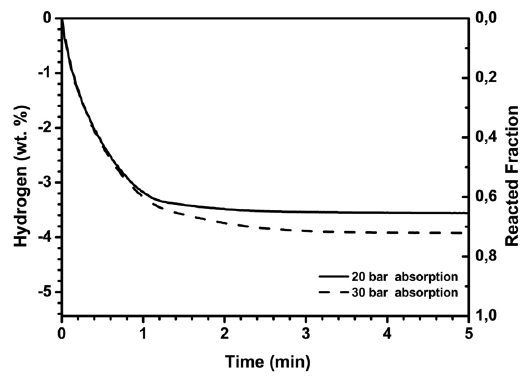
Figure 5. Curves of hydrogen desorption kinetics of 2Mg-Fe sample at 350 °C under 1.6 bar of H . The hydrogen desorption behaviour 2 was measured after the hydrogen absorption tests at 350 °C under 20 and 30 bar of H during 20 2